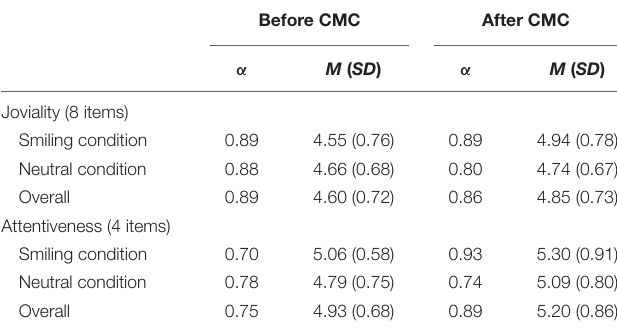
TABLE 2 | Cronbach’s alpha, means, and standard deviations of self-report measures, as a function of experimental condition. Before CMC After